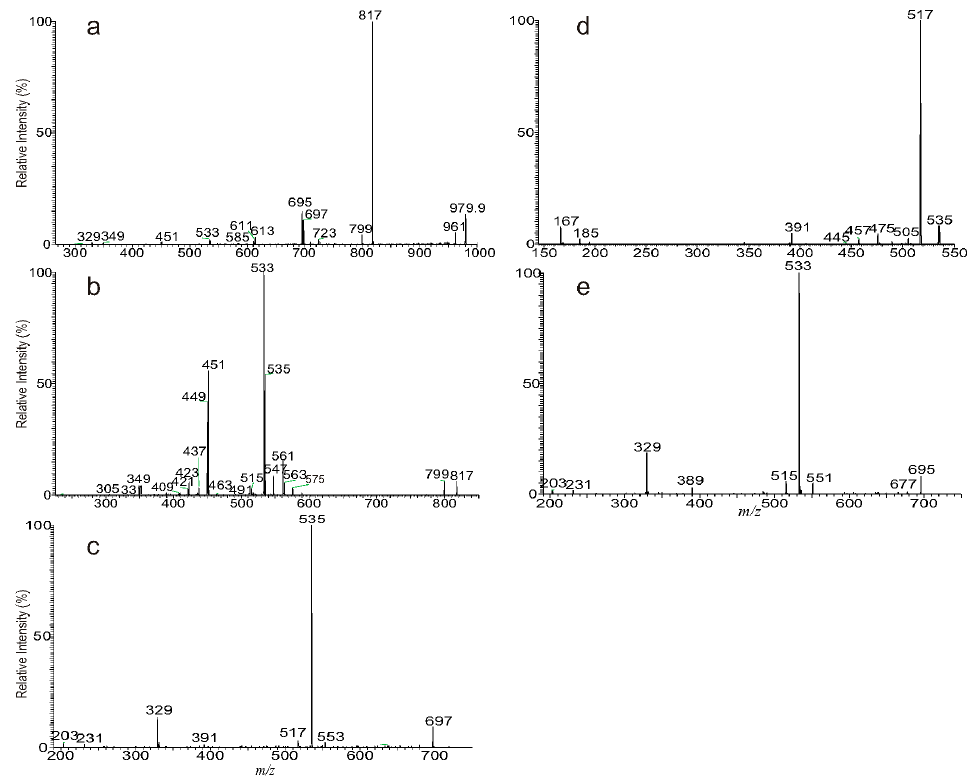
Figure 3. The MS 2 spectrum of the [M + Na] + ions of m/z 979 ( a ), its MS 3 spectra of the ions of m/z 817 (979 → 817)) ( b ), of m/z 697 (979 → 697) ( c ), its MS 4 spectrum of the ions of m/z 535 (979 → 817 → 535) ( d ); and